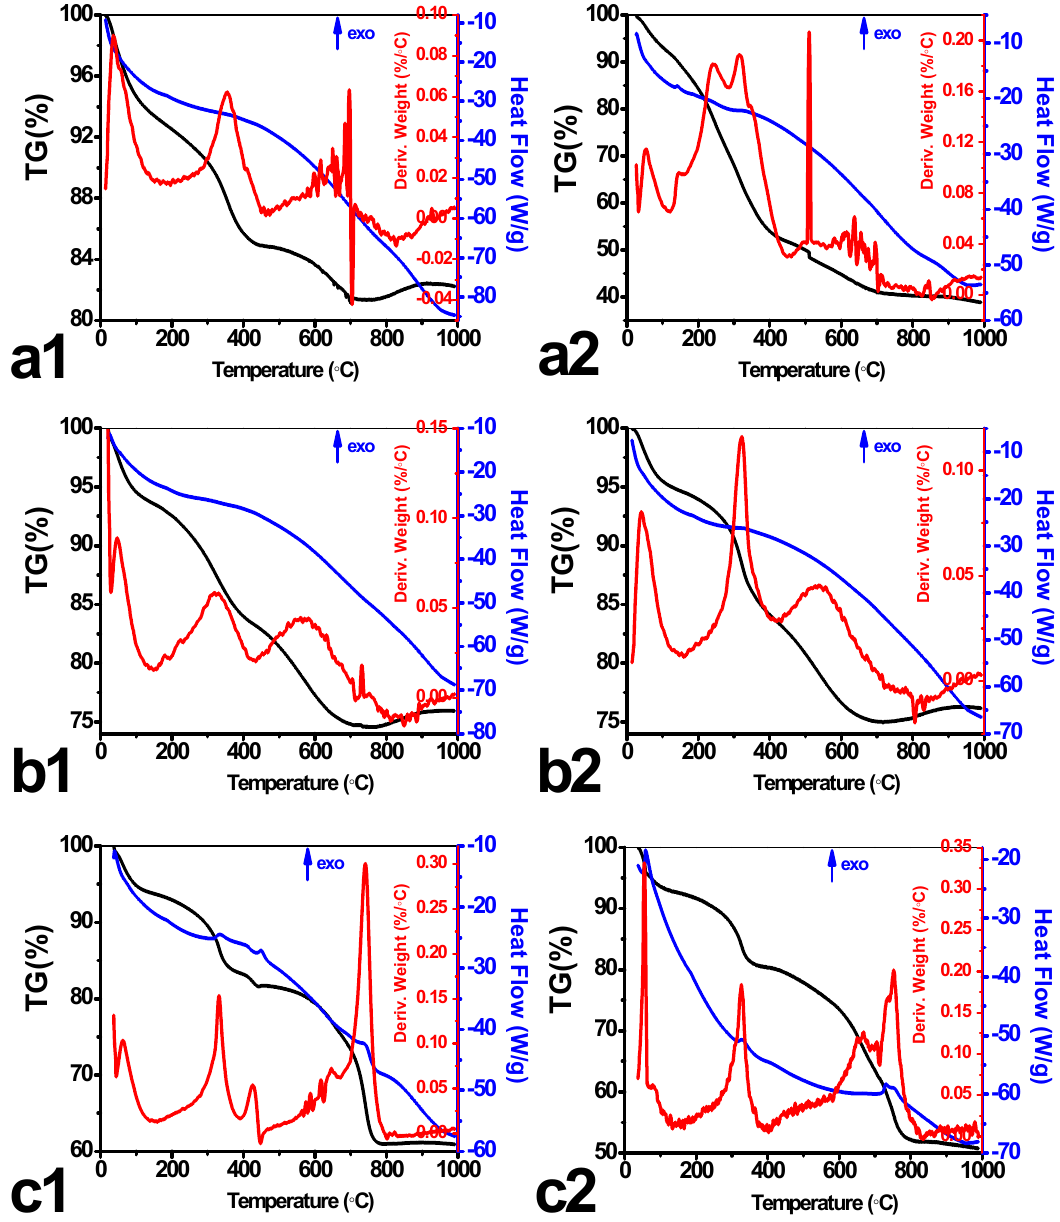
Figure 5. The TGA ‐ DSC profiles of pristine ( a1 – c1 ) and leached ( a2 – c2 ) tin alkylphosphonates: ( a ) Sn ‐ ATMP; ( b ) Sn ‐ EDTMP; ( c ) Sn ‐ DTPMP.